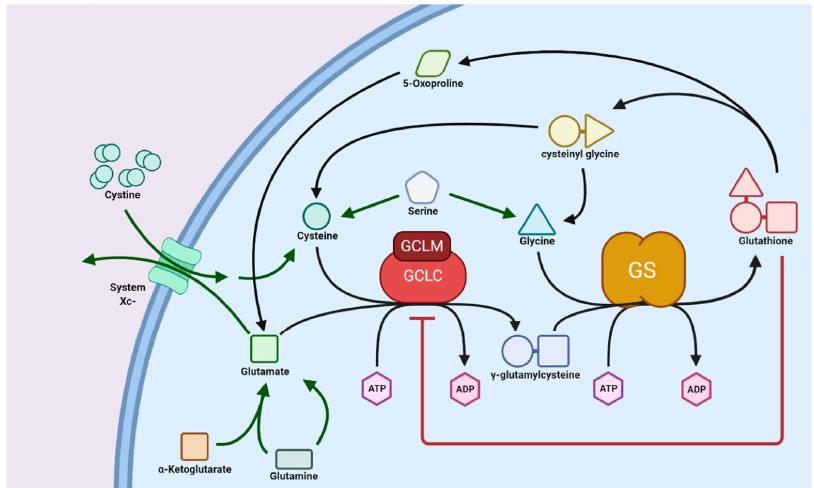
Figure 2. Schematic showing biosynthesis of glutathione. Reproduced with permission from [15].